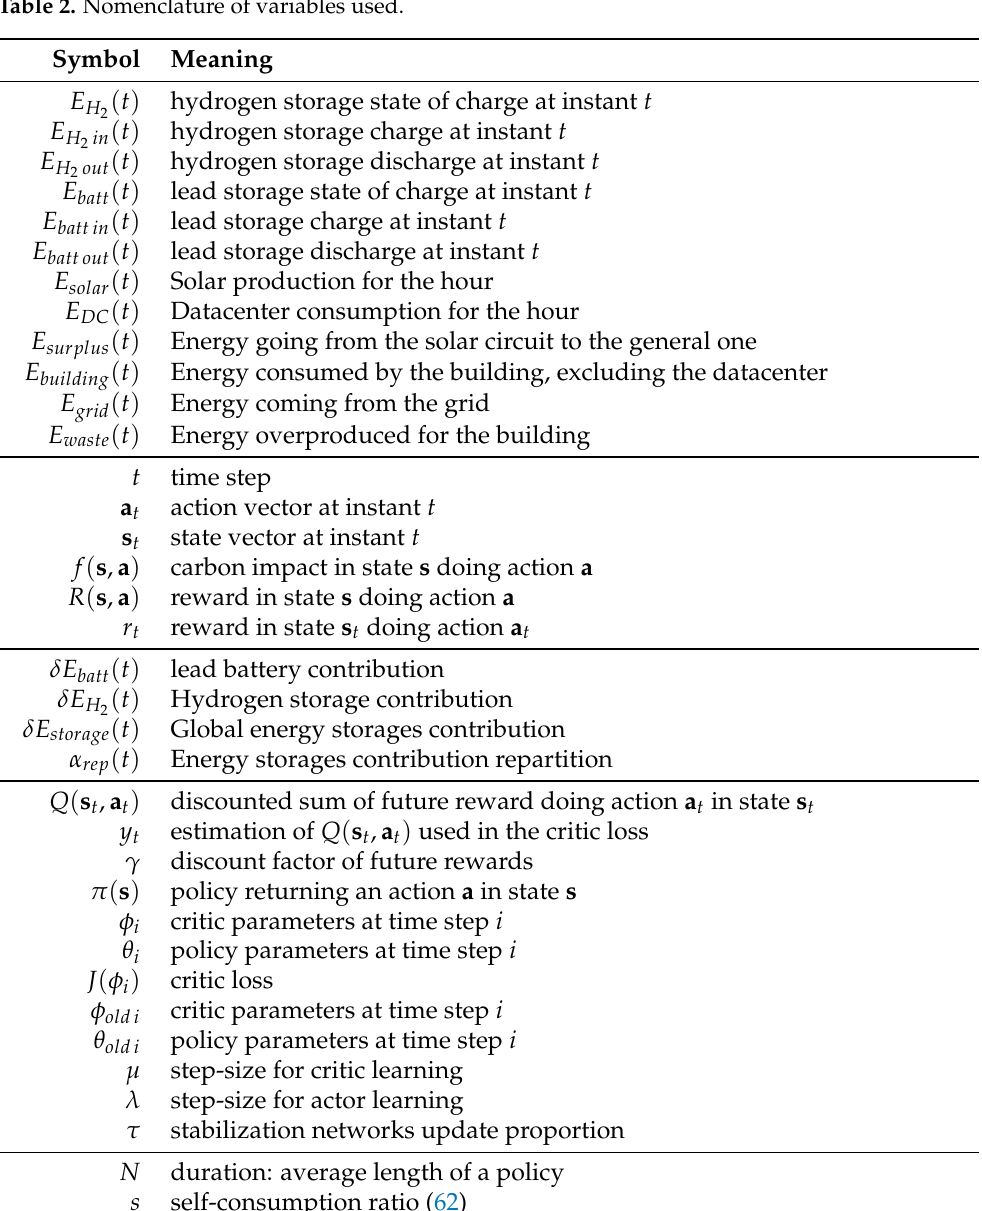
Table 2. Nomenclature of variables